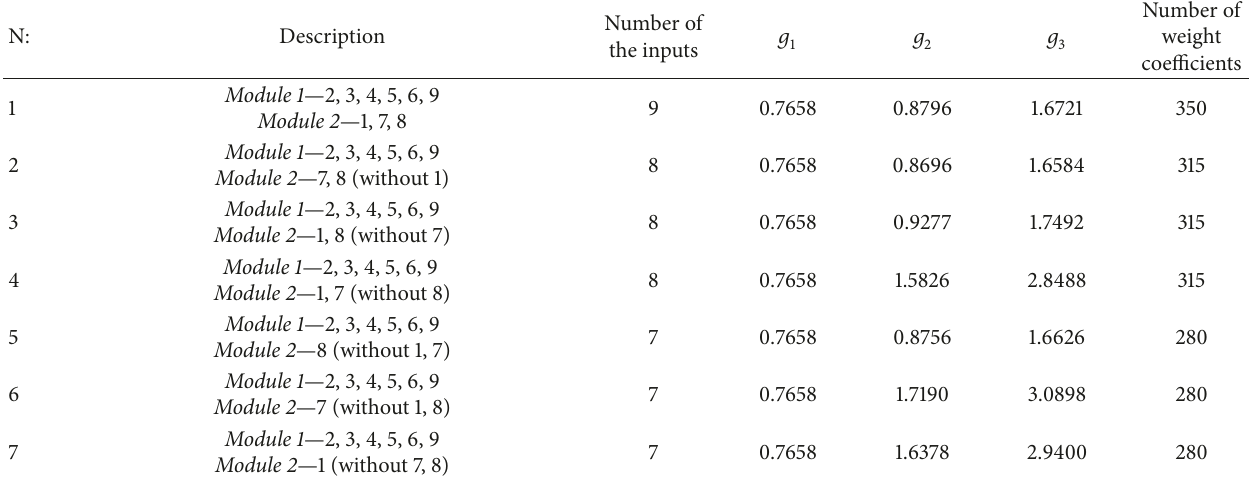
Table 10: Results from the simulations.